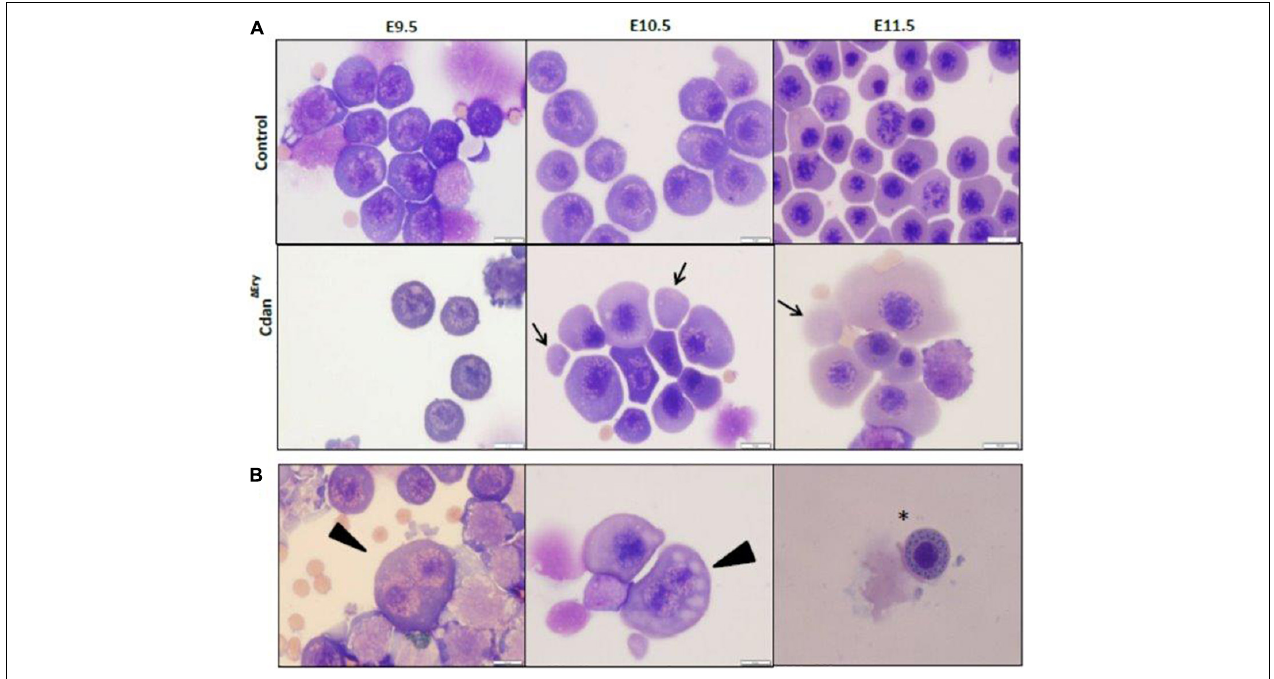
FIGURE 2 | Erythroid-specific knockout of Cdan1 recapitulates the CDA-I phenotype. (A) Morphology of Cdan (cid:49) Ery circulating erythroblasts, compared to littermate controls. Cytospins were prepared from blood samples collected from E9.5 to E11.5 yolk sacs and embryos. The arrows mark primitive enucleated cells. Scale bar = 10 µ m. (B) Cdan (cid:49) Ery erythroblasts show aberrant morphology including binuclear cells (arrowhead) and basophilic stippling (asterisk). Scale bar = 10 µ